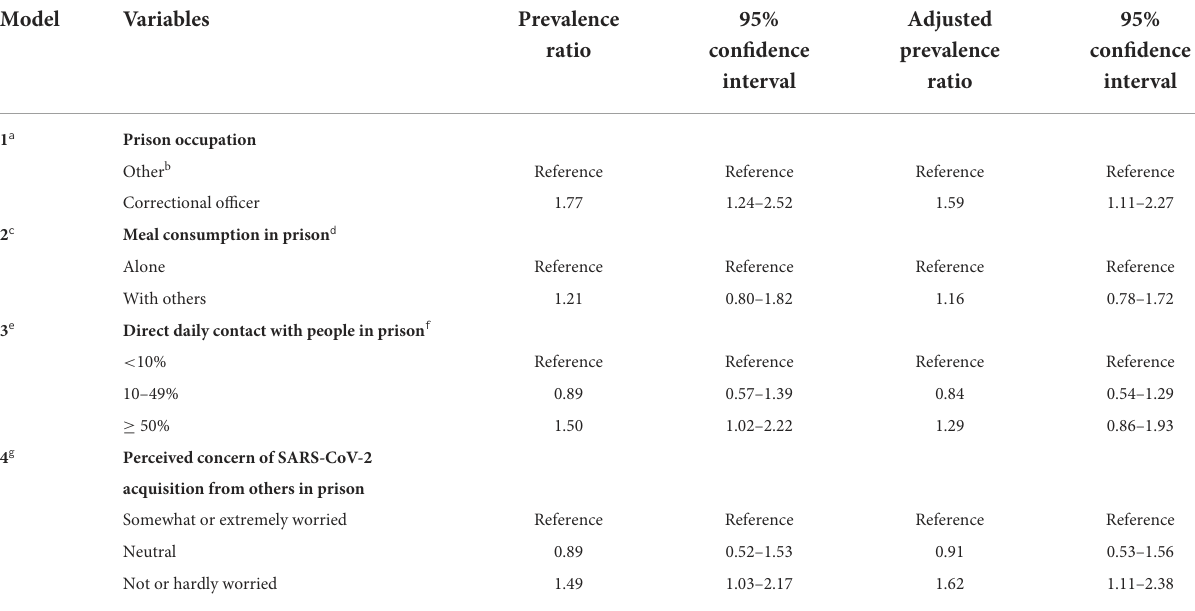
TABLE 2 Unadjusted and adjusted associations between carceral exposures of interest and SARS-CoV-2 seropositivity among correctional workers in three provincial prisons in Quebec, Canada (2021).